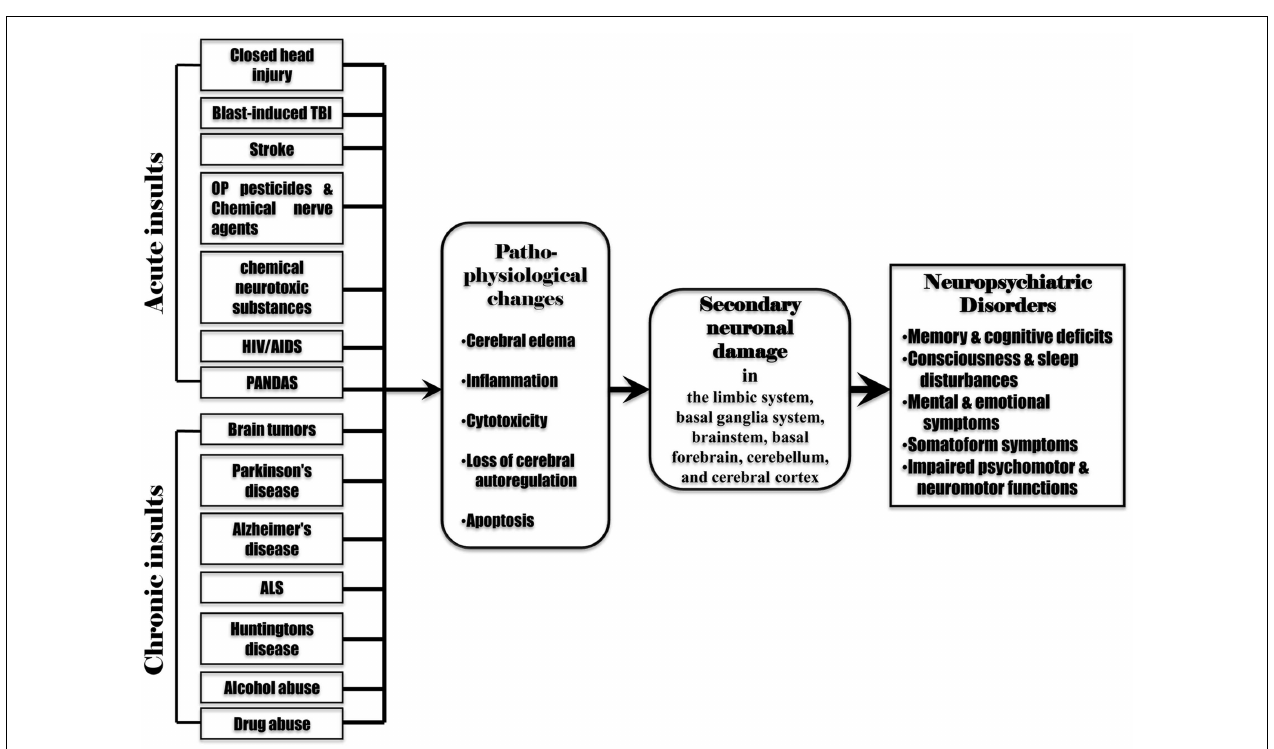
secondary neuronal damage in the brain regions remote from the initial injured site (the limbic system, basal ganglia system, brainstem, basal forebrain, cerebellum, and cerebral cortex), leading to subsequent neuropsychiatric